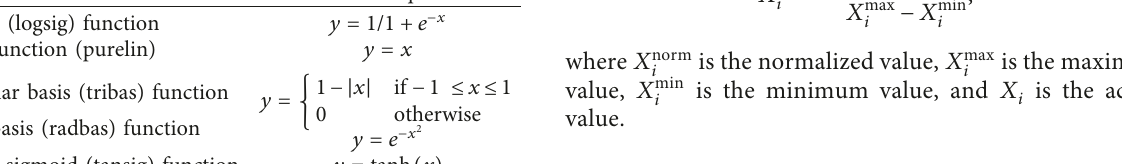
Table 2: Equation of different types of activation functions. Name of activation